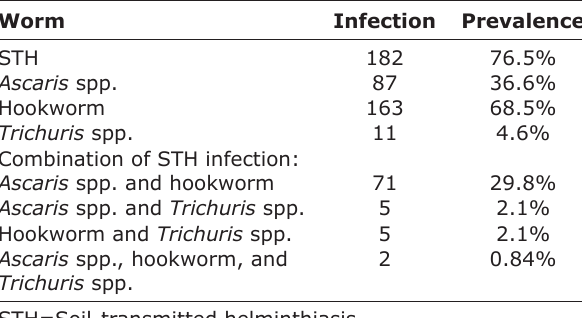
Table-2: STH infection in the traditional pig farm.